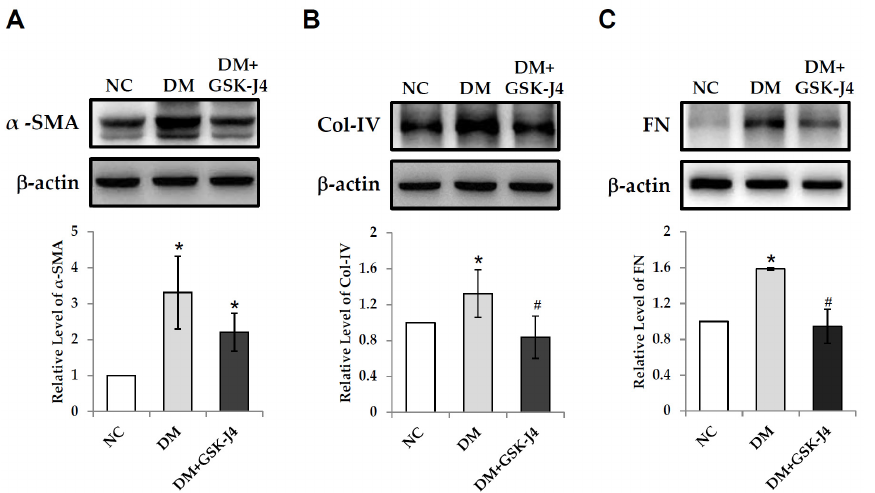
Figure 4. GSK-J4 reduces renal fibrosis-associated proteins in STZ-induced diabetic mice. Western blot analysis of kidney protein levels in C57BL/6 mice (NC), STZ-induced diabetic mice (DM), and STZ-induced diabetic mice that were treated with GSK-J4 (DM + GSK-J4) that were detected using ( A ) α -SMA, ( B ) collagen IV, and ( C ) fibronectin antibodies. The lower panel shows the relative quantification of α -SMA, collagen IV, and fibronectin in the Western blot analysis, respectively. * p < 0.05 versus the control group; # p < 0.05 DM versus DM + GSK-J4. Abbreviations: DM, STZ- induced diabetic mice; FN, fibronectin; Col-IV, collagen IV; and NC, normal